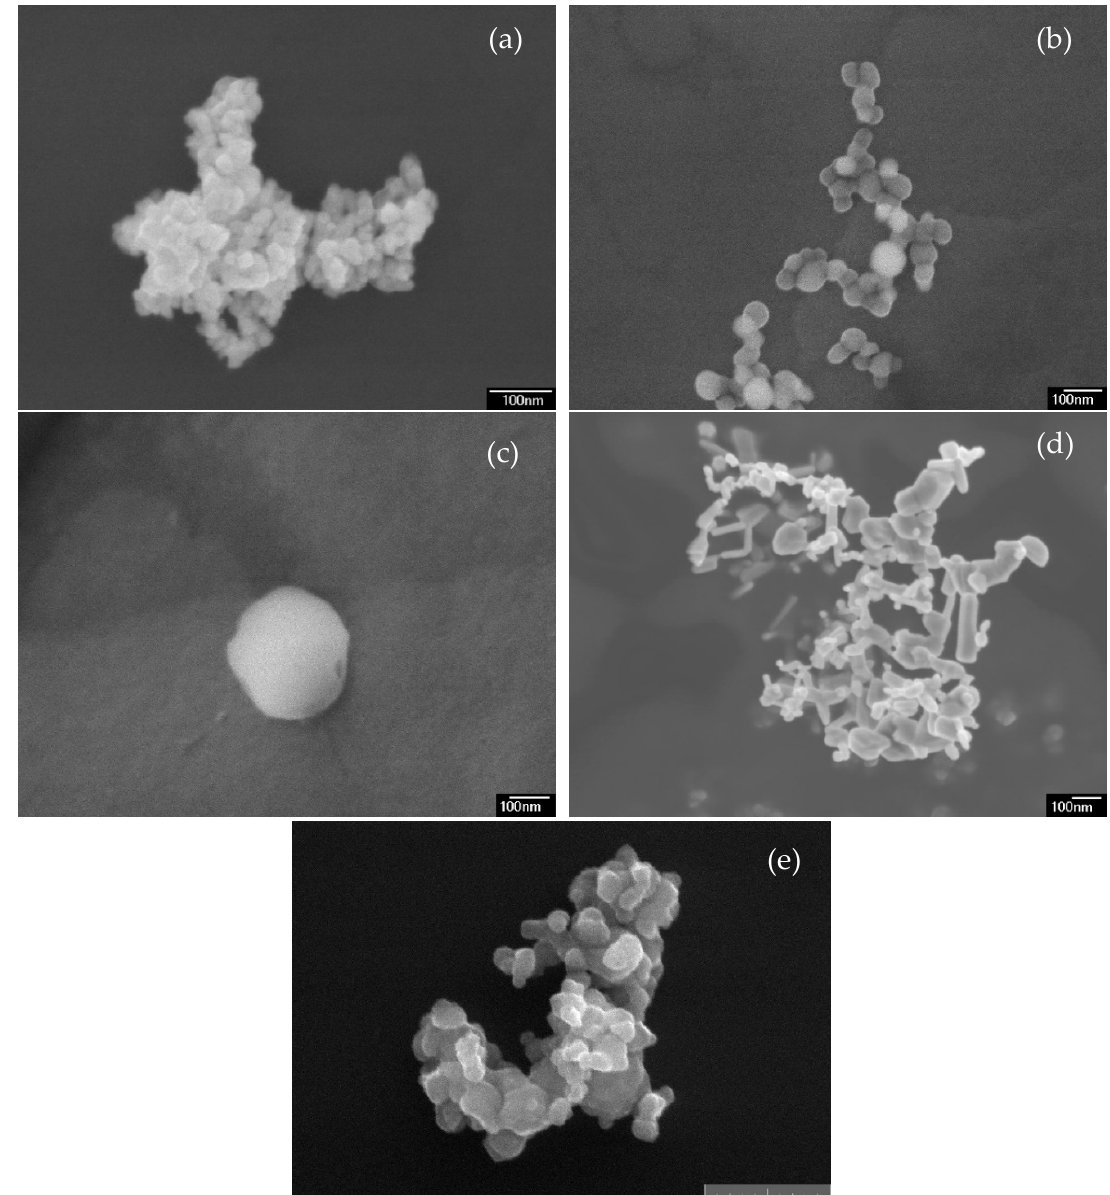
Figure 3. Micrographs of CeO 2 ( a ‐ c ), ZnO ( d ), and Cu ( e ) NPs.